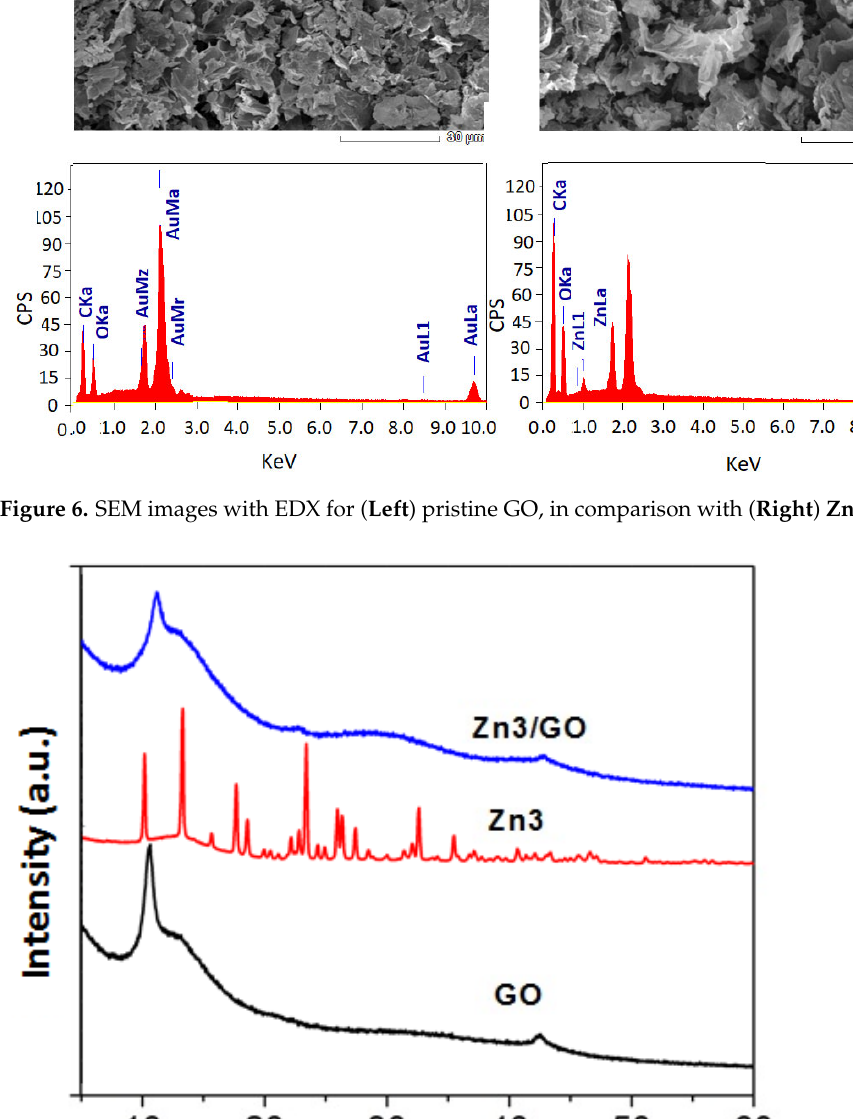
Figure 8. ( a ) optimized structure of Zn3 , ( b ) optimized structure of GO, ( c ) the MESP map and ( d ) the HOMO orbitals of GO nanosheet calculated at B3LYP/6– 311++G(d,p) level of theory.